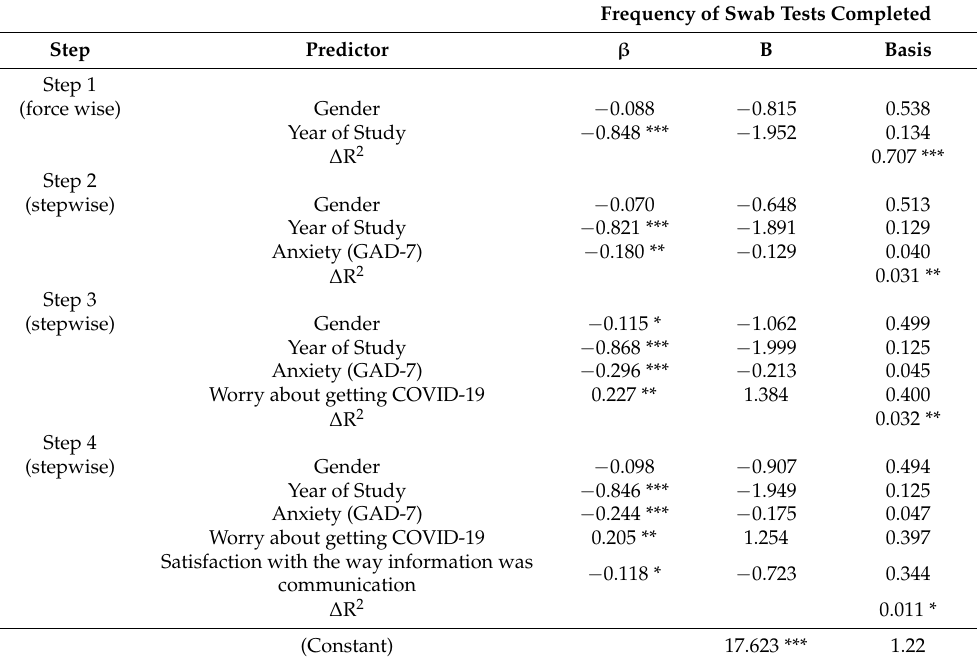
Table 8. Summary of hierarchical regression analysis of variables predicting number of PCR (swab/saliva) tests